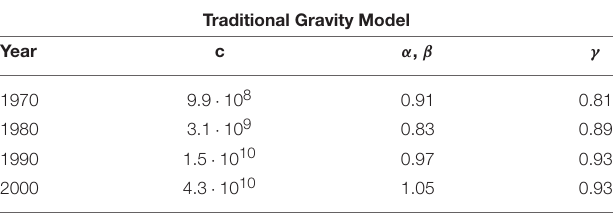
TABLE 1 | Parameter values for the traditional Gravity Model used in Figure 1 and calculated by fitting Equation (1) (with the symmetry constraint α ≡ β ) to all non-zero empirical bilateral trade flows via an Ordinary Least Square (OLS) regression of log-transformed